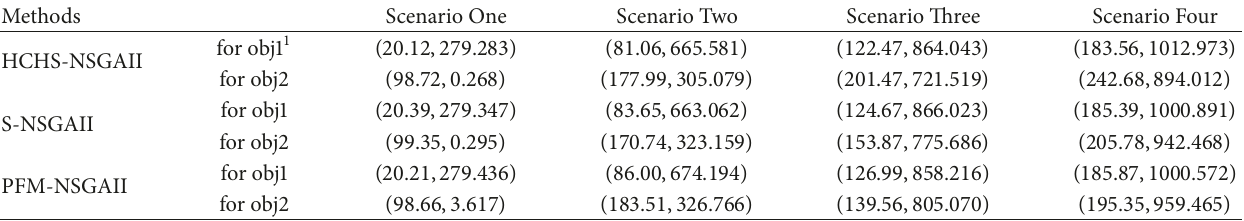
Table 2: The best extreme feasible solutions for the minimum cost and emission using the three